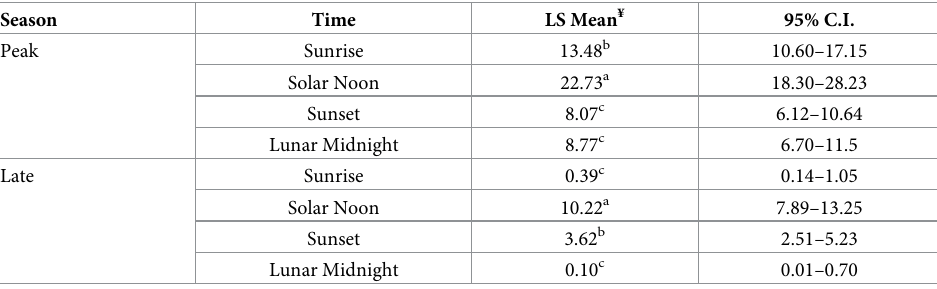
Table 1. Least square means from log-linear analysis of New Jersey human sweep netting counts of all Aedes albo- pictus for ten study sites over two seasons (peak and late) and four time periods: Sunrise, Solar Noon, Sunset, and Lunar Midnight.